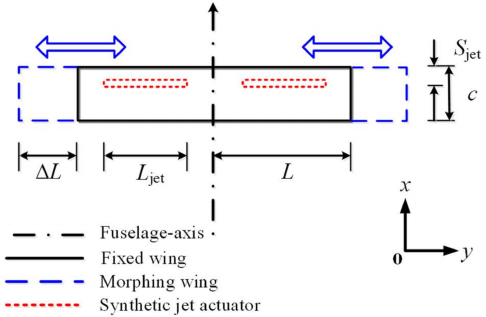
Figure 1. Top view of morphing aircraft with a synthetic jet actuator